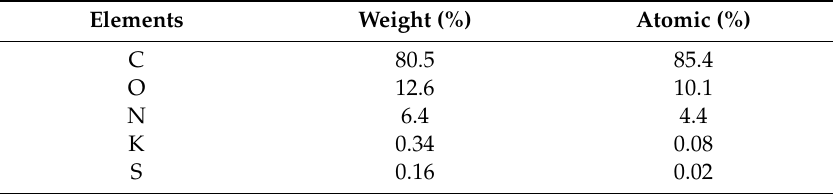
Figure 3. ( a ) TEM micrograph and particle size distribution, ( b ) SEM micrograph and ( c ) Raman spectrum of prepared nano-activated carbon (NAC). Table 4. Chemical composition of prepared NAC using EDX